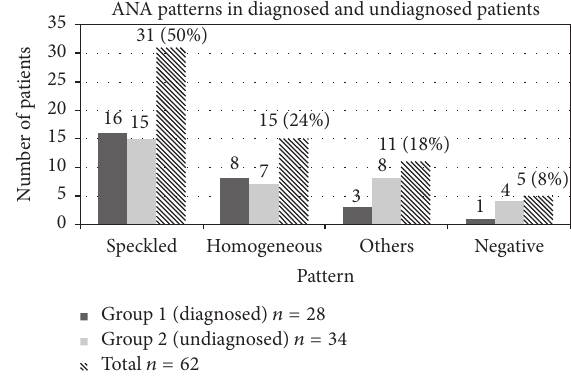
Figure 4: Distribution (in number of patients) of ANA patterns and ANA-negative results obtained in each group of